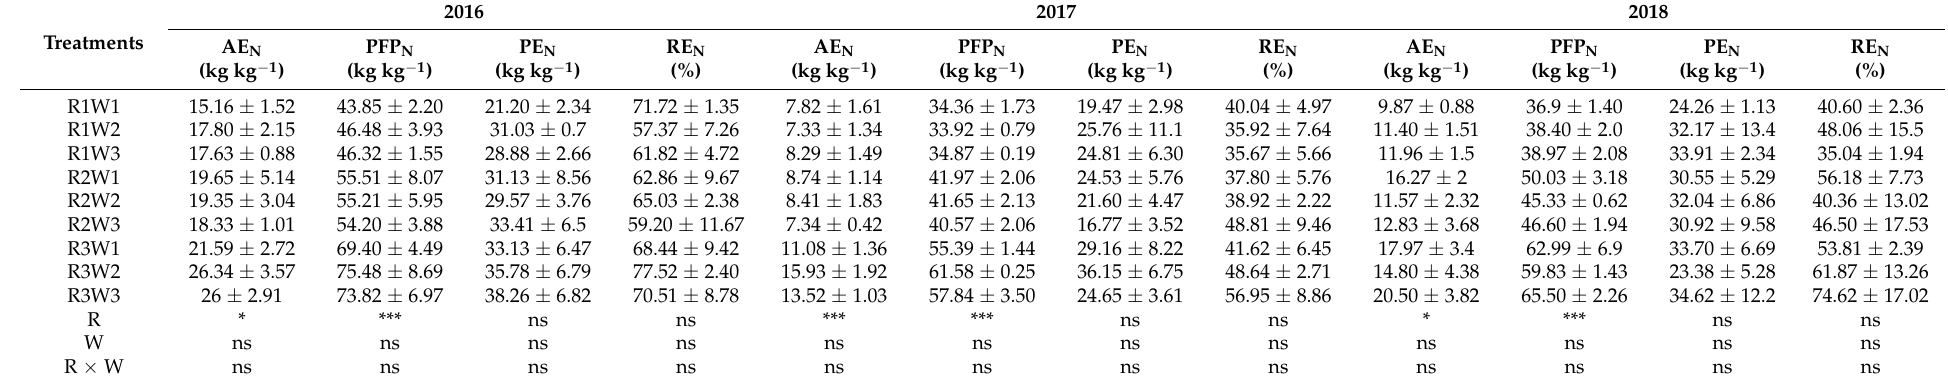
Table 6. Indices of NUE under different N input rates during rice seasons in the three-year experiment (2016–2018).